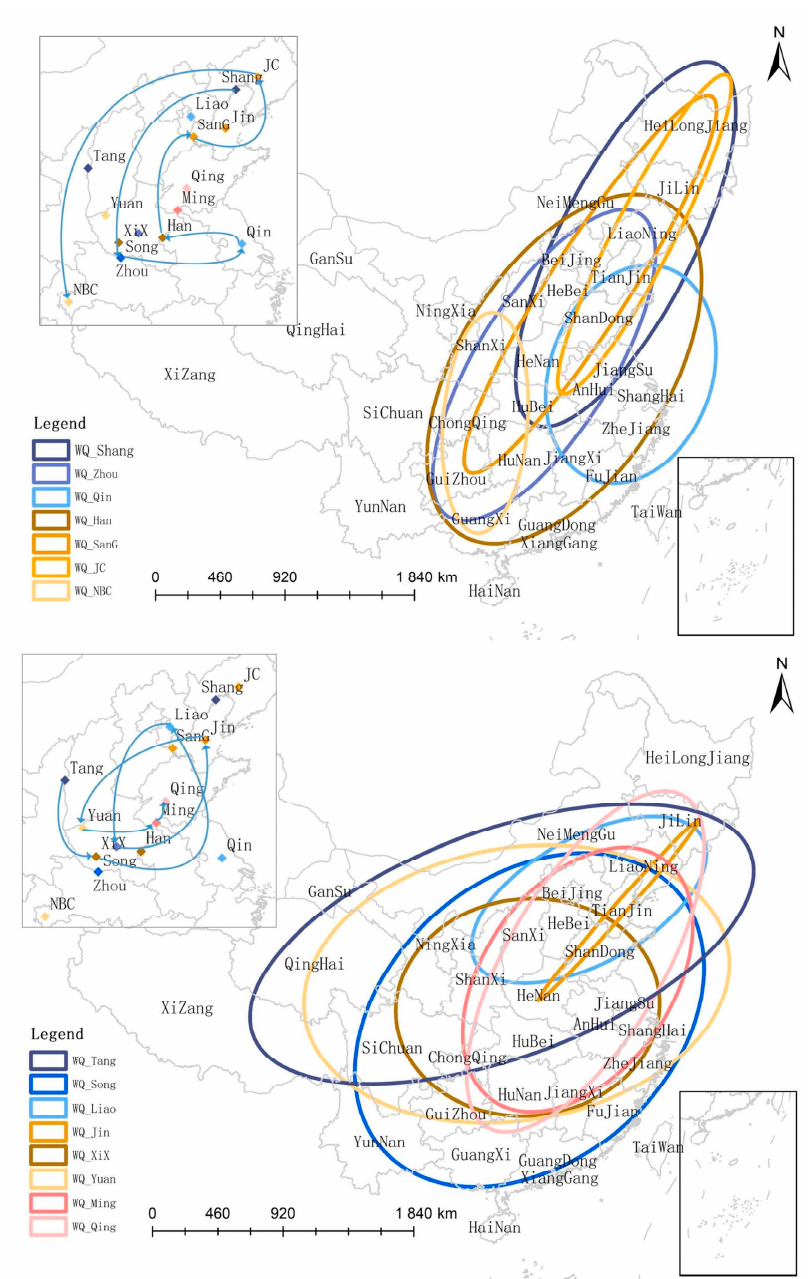
Figure 8. Center of gravity migration path and standard deviation ellipse of weapon relics from the Shang Dynasty to Northern and Southern Dynasties (up) and the Tang Dynasty to Qing Dynasty (down).